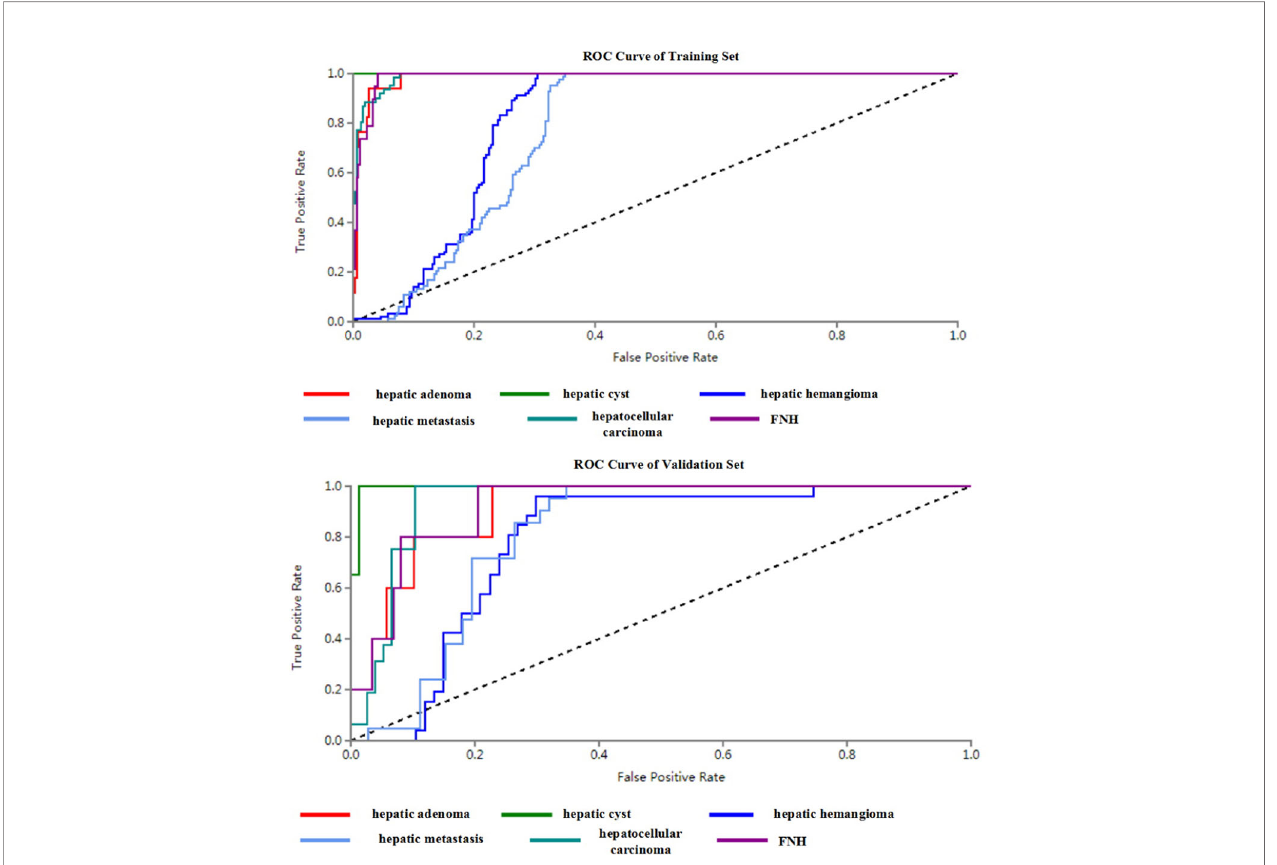
FIGURE 3 | ROC curves of SVM methods to classi fi cation (six kinds of focal hepatic